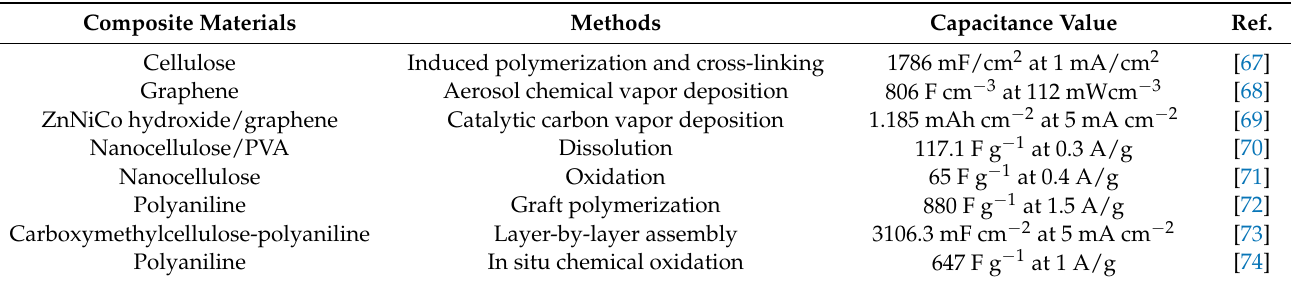
Table 2. Comparisons of supercapactive performance of CNT-based hydrogels using various com- posite